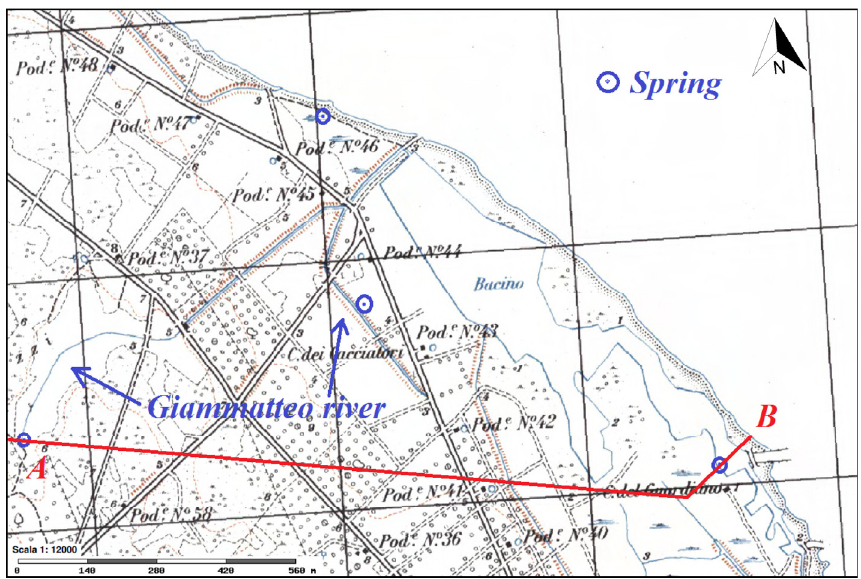
Figure 6. 1948 topographic map by Istituto Geografico Militare (Italian Geographical Army) with the localization of the springs (blue circles), showing the situation after reclamation works. The terminal part of Giammatteo River bounds to the north the Acquatina di Frigole lagoon. The red line indicates trace of the section shown in Figure 7.